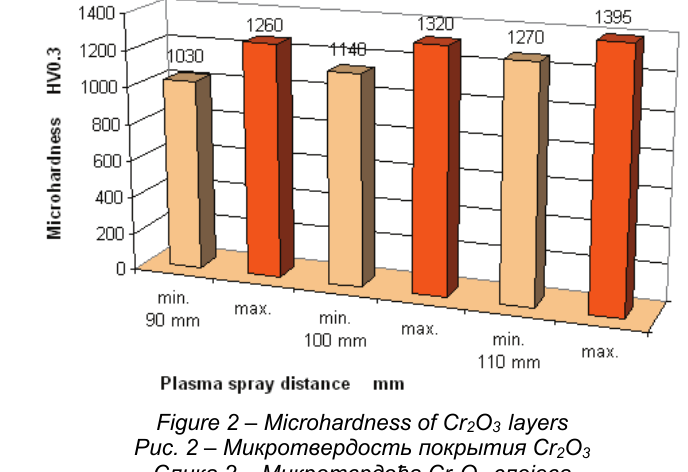
Figure 2 – Microhardness of Cr 2 O 3 layers Рис . 2 – Микротвердость покрытия Cr 2 O 3